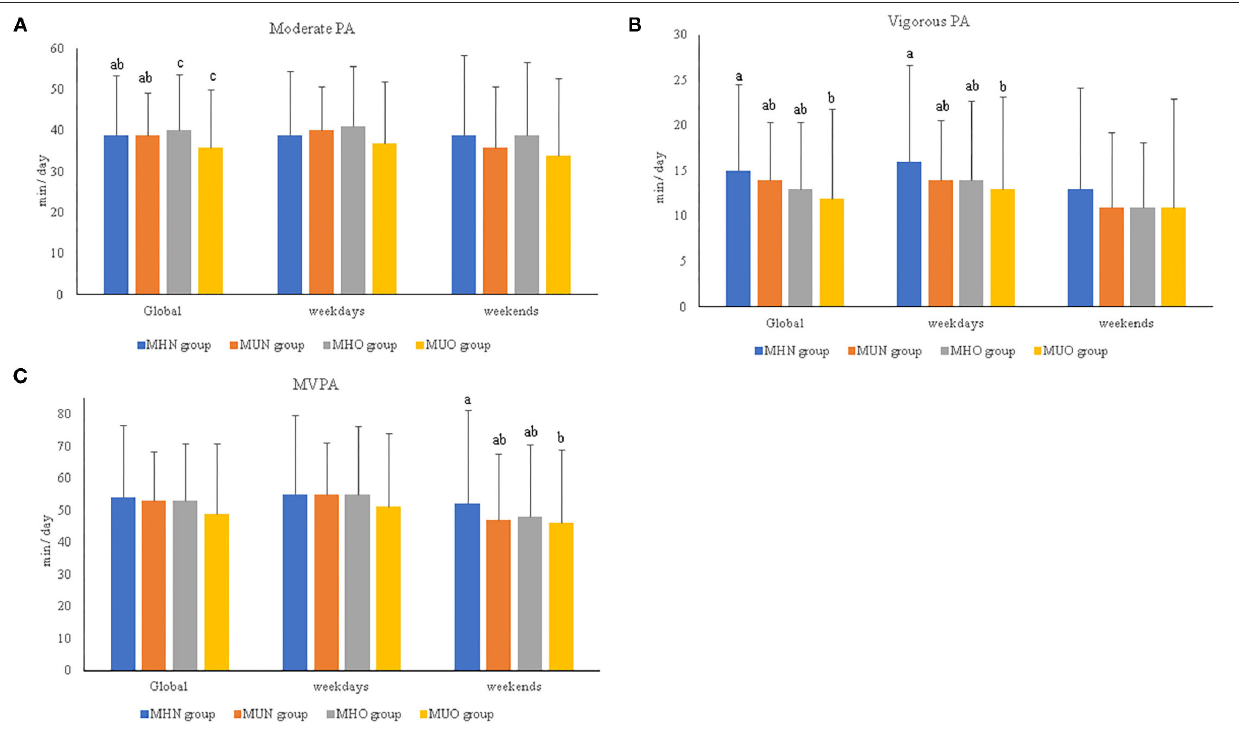
independently, the MUO boys showed a lower time engaged in moderate-intensity PA ( p = 0.019) than the MHO boys, as